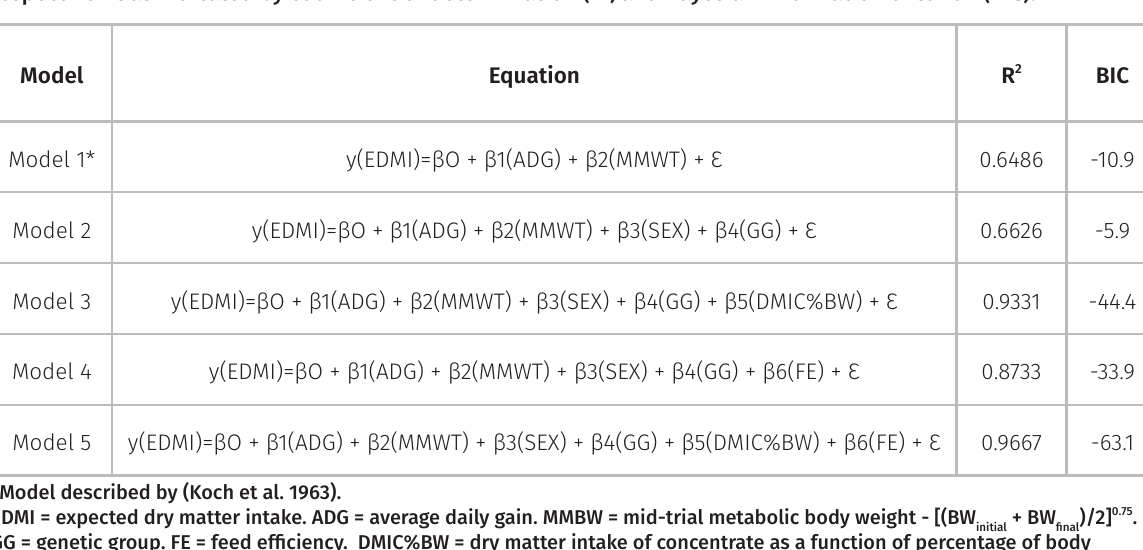
Table II. Predictive equation models used to estimate feed intake for the calculation of residual feed intake and respective fit as indicated by coefficient of determination (R 2 ) and Bayesian information criterion (BIC).